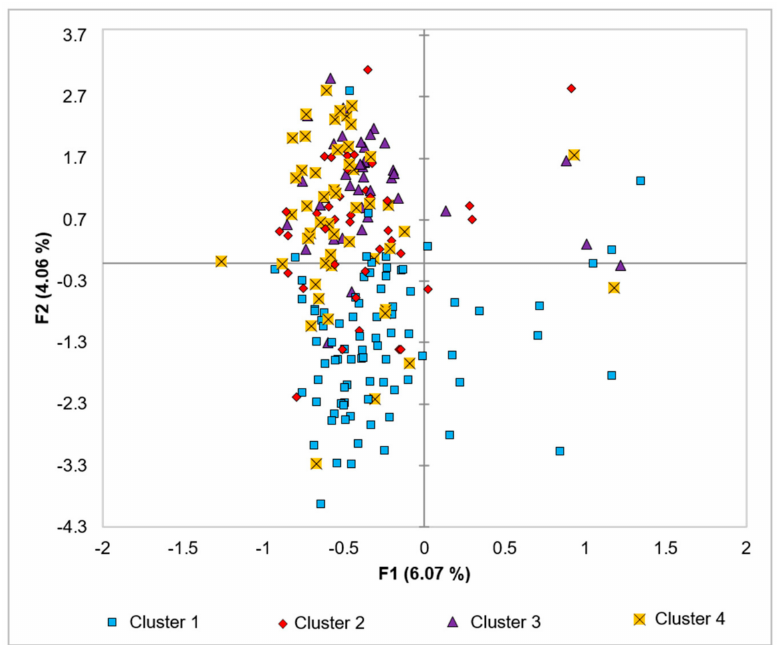
Figure 8. Principal components analysis of mixed data (PCAmix) demonstrating the morphological relationships among individuals of the four clusters.